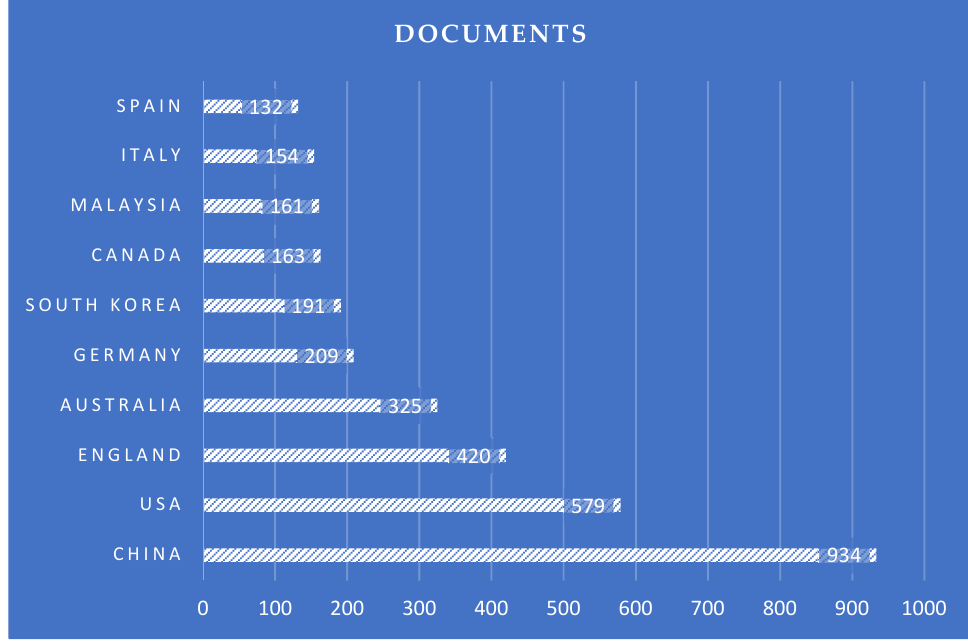
Figure 4. Top publications per country.